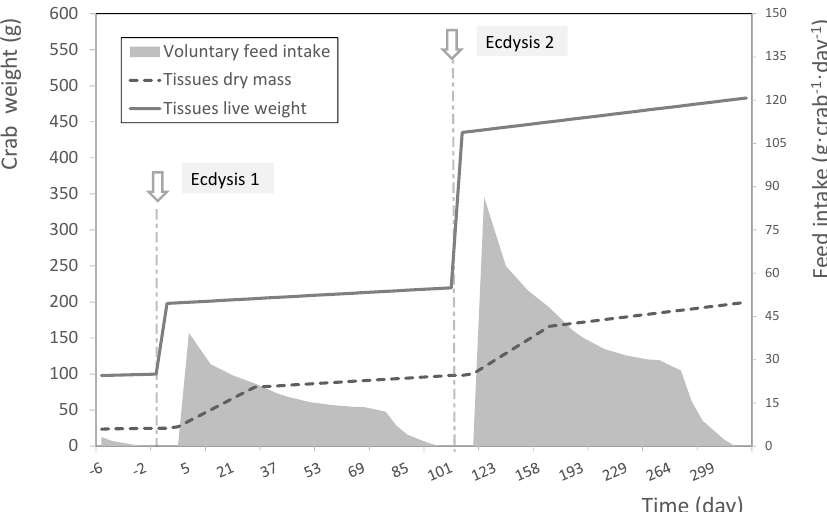
Figure 6. Schematic model of growth in live (based on 100 g just before ecdysis 1) and dry mass gain and voluntary food intake (VFI) of juvenile crabs during two molting cycles. The duration of the first molt cycle (MC1) was determined by our study. The duration of the second molt cycle (MC2) was calculated based on the results of [10] and is 1.24 times (+24%) that of MC1. A total of 80% of tissues dry mass growth was observed during the first 30% of the molt cycle, and the remaining 20% during the rest of molt cycle. VFI is dependent on tissues growth, which dramatically increases following the fast tissues growth period and then decrease until the next ecdysis.